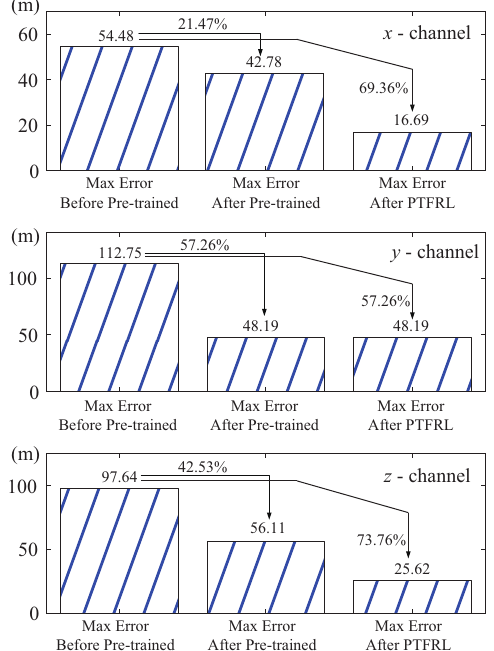
Figure 8. Comparisons of the max tracking errors in different